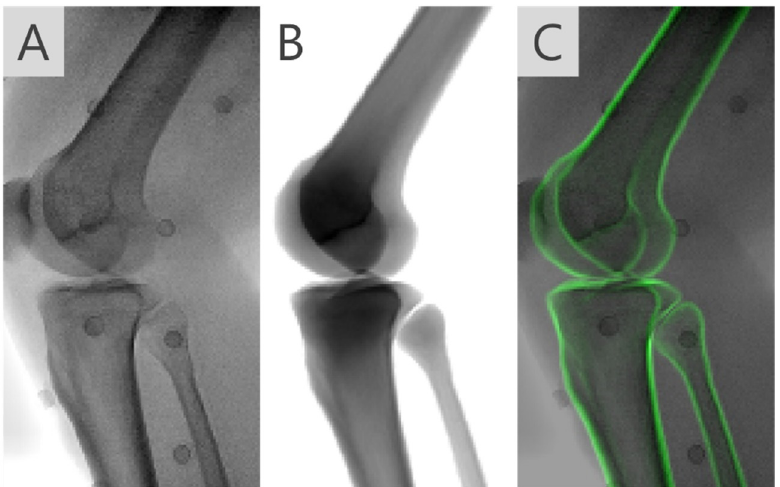
Figure 4. ( A ) X-ray fluoroscopic image of the knee joint during a tested activity and ( B ) the combined digitally reconstructed radiograph (DRR) of both the femur and tibia given the registered pose parameters. ( C ) The DRR overlaid on the fluoroscopic images visually showed the agreement between the two images.